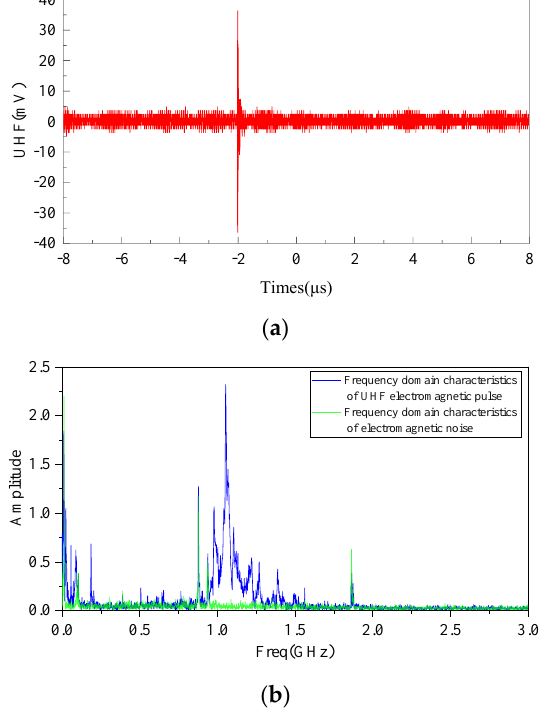
Figure 18. Metal filth discharge defects: ( a ) time domain characteristics; ( b ) frequency domain characteristics.